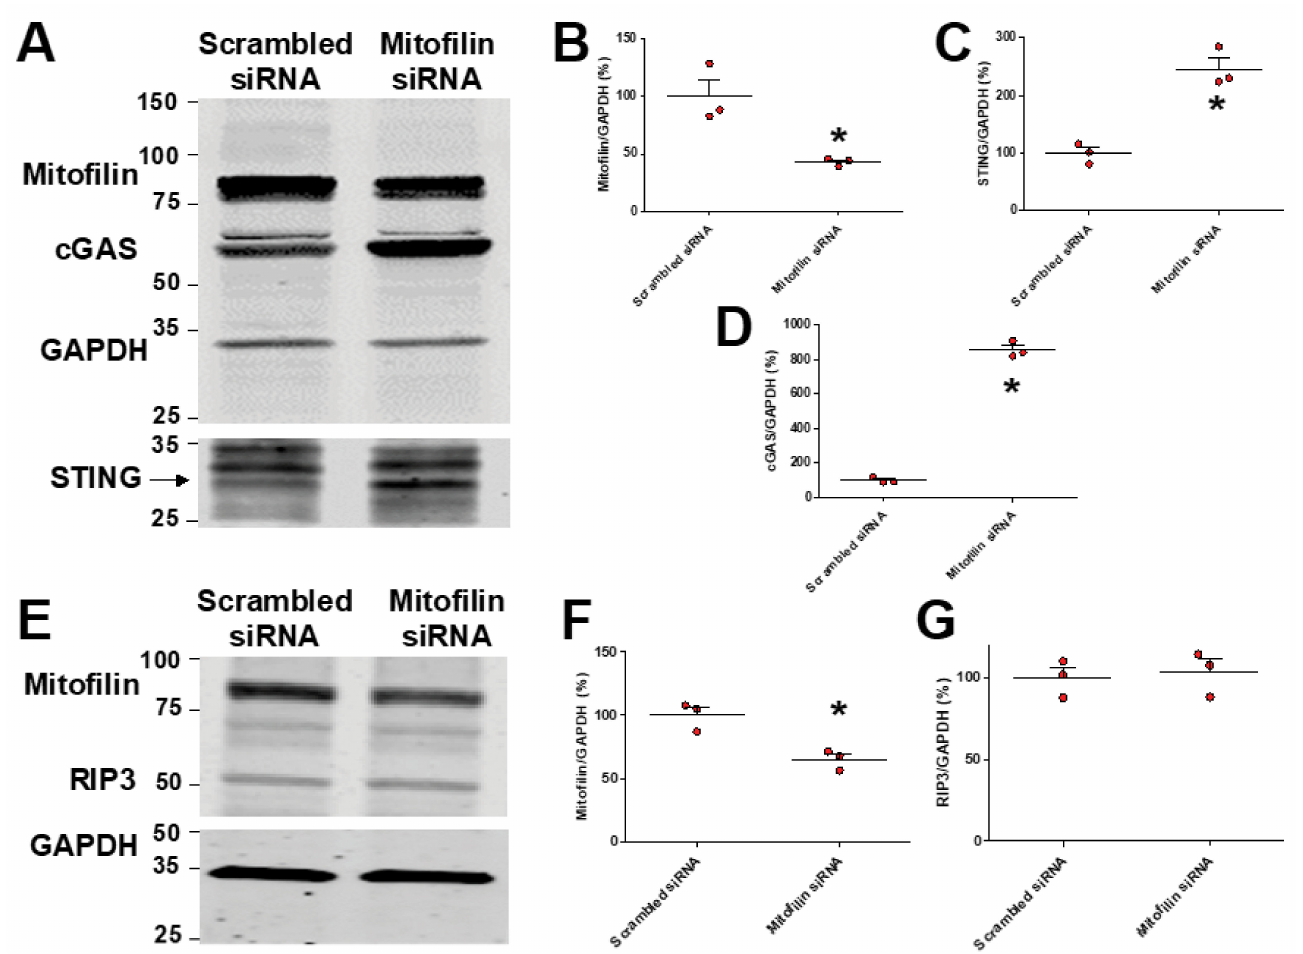
Figure 9. Mitofilin knockdown in HK-2 cells increases the levels of cGAS and STING, with no effect on RIP3 levels. ( A ) Immunoblots showing increases in the levels of cGAS and STING in HK-2 cells transfected with Mitofilin siRNA compared to those transfected with scrambled siRNA ( n = 3 experiments). ( B – D ) Graph showing increases in the levels of cGAS ( D ) and STING ( C ) and reductions in Mitofilin ( B ) levels in HK-2 cells transfected with Mitofilin siRNA compared to those transfected with scrambled siRNA. Values are expressed as means ± SEM; * p < 0.05 versus control (Ctrl) vector group ( n = 3/group). ( E ) Immunoblots showing no difference in the levels of RIP3 in HK- 2 cells transfected with Mitofilin siRNA compared to those transfected with scrambled siRNA ( n = 3 experiments). ( F , G ) Graph showing reductions in Mitofilin ( F ) levels and no change in RIP3 levels ( G ) in HK-2 cells transfected with Mitofilin siRNA compared to those transfected with scrambled siRNA. Values are expressed as means ± SEM; * p < 0.05 versus control (Ctrl) vector group ( n =